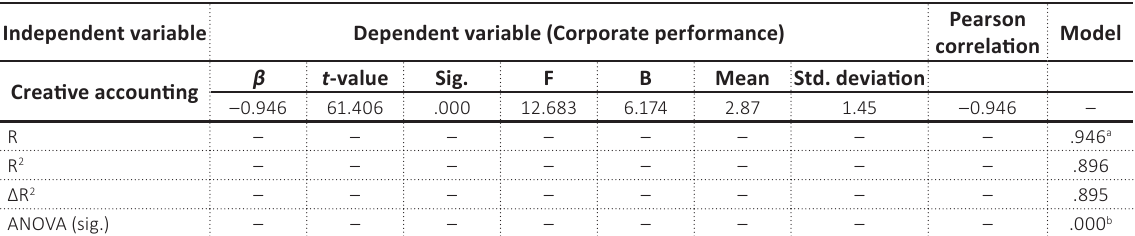
Source: Authors’ elaboration.